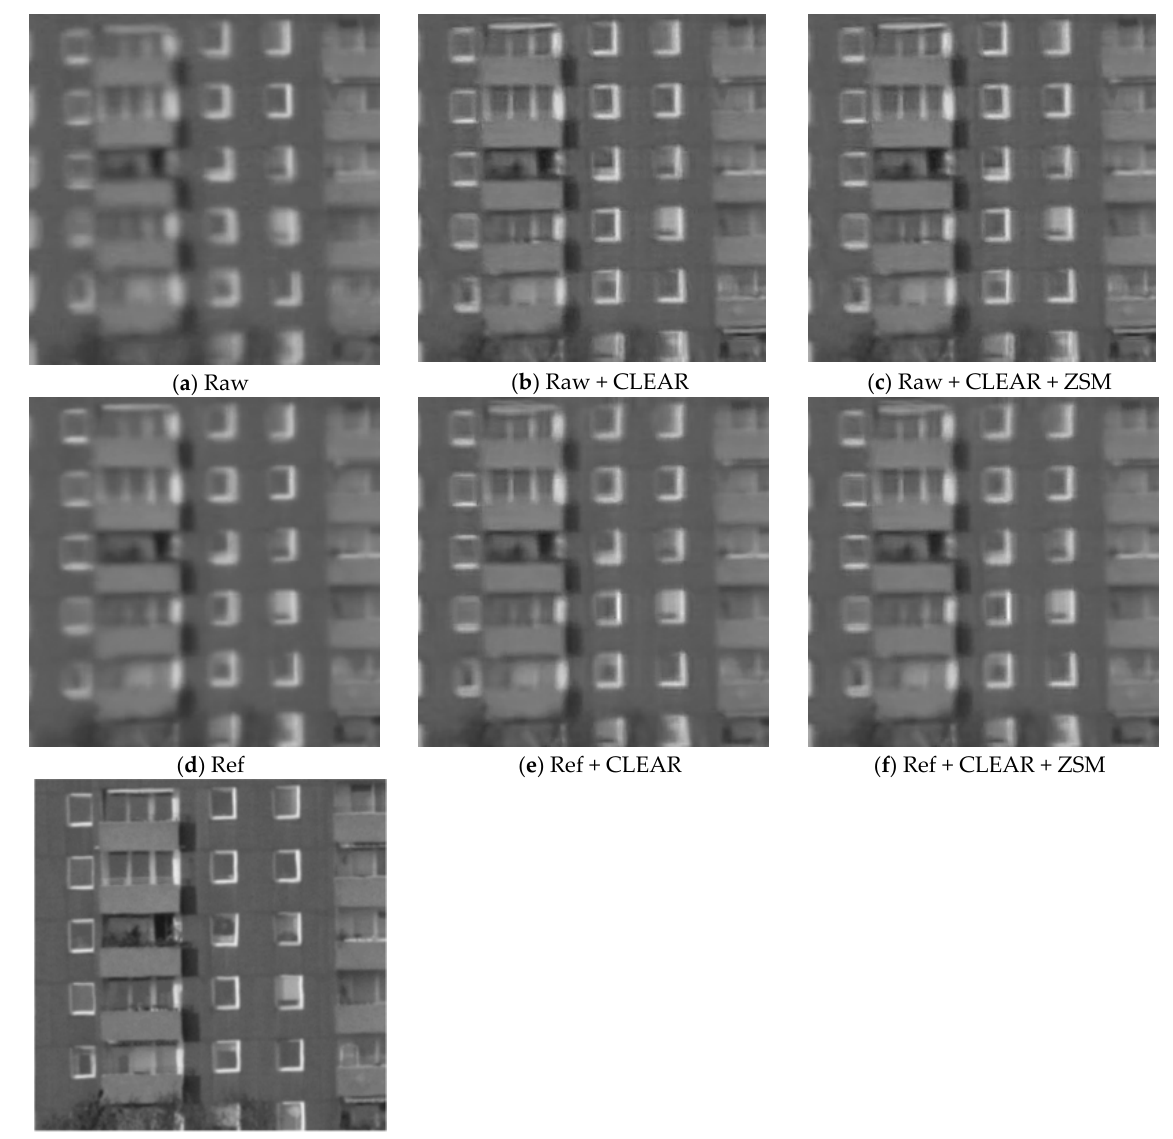
Figure 8. Method comparisons of the ‘Chimney’ sequence. ( a ) Raw; ( b ) Raw+CLEAR; ( c ) Raw+CLEAR+ZSM; ( d ) Ref; ( e ) Ref+CLEAR; ( f ) Ref+CLEAR+ZSM; ( g ) Ground truth.